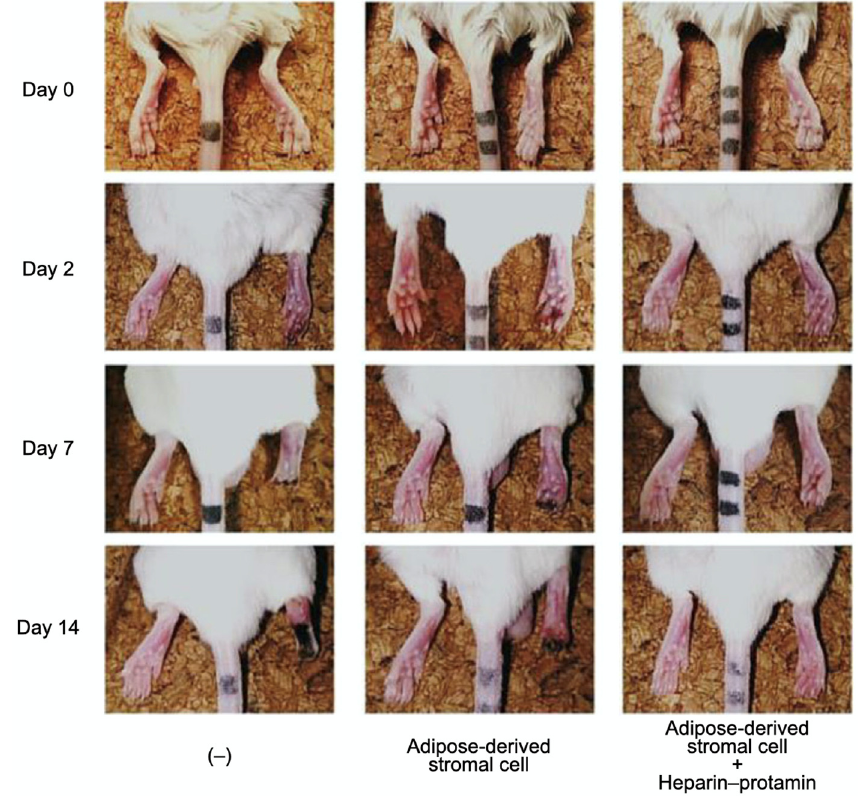
Figure 5. Amelioration of limb ischemia in a mouse model by the transplantation of adipose-derived stromal cell aggregates with heparin–protamine particles. Adapted from ref. [82].